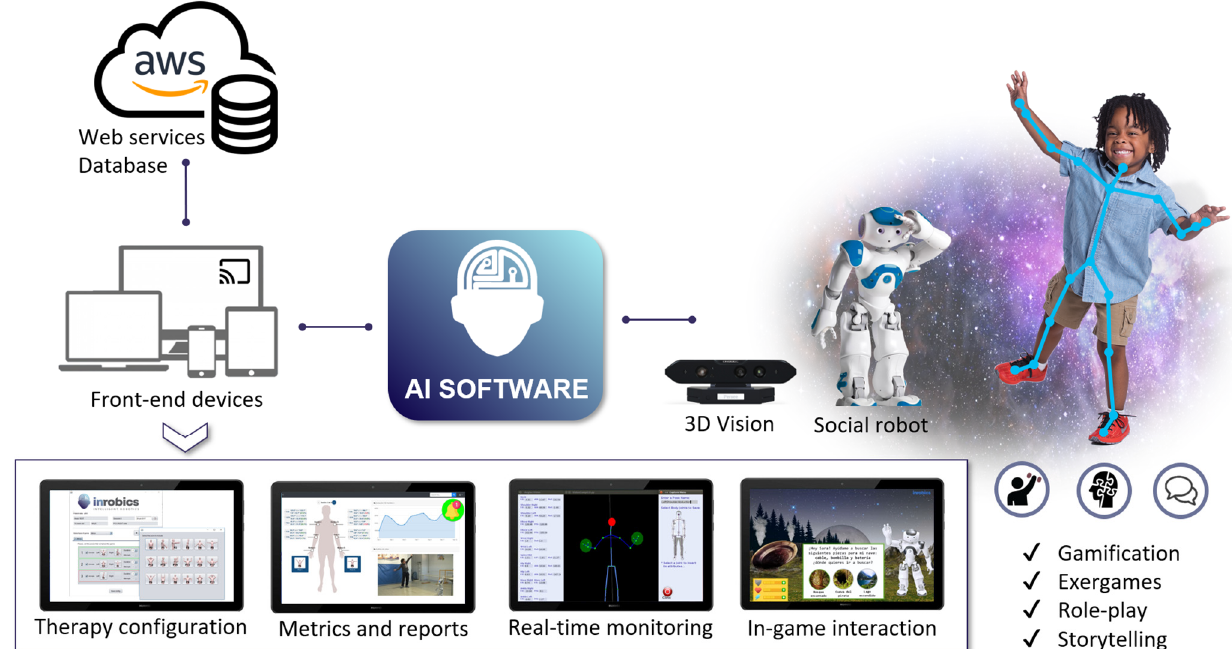
Figure 1. Inrobics Rehabilitation Clinical Platform.